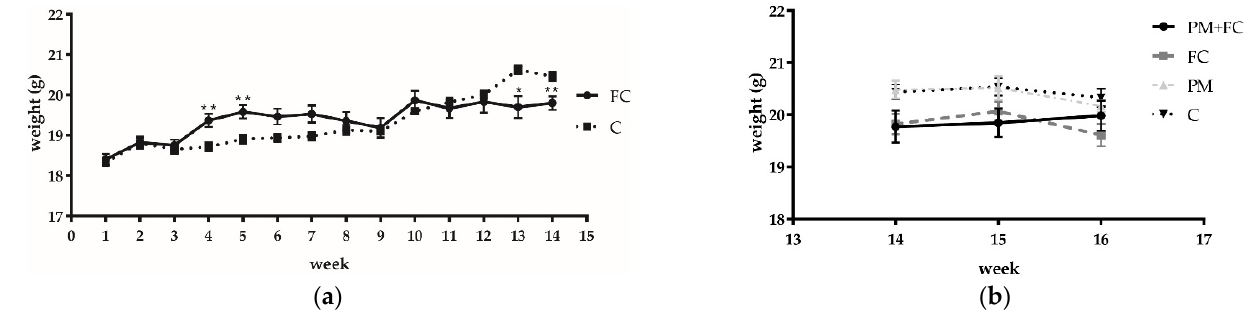
Figure 4. Mice weight monitoring data of each week before ( a ) and after ( b ) PM2.5 nasal drip experiment. * p < 0.05, ** p < 0.01.